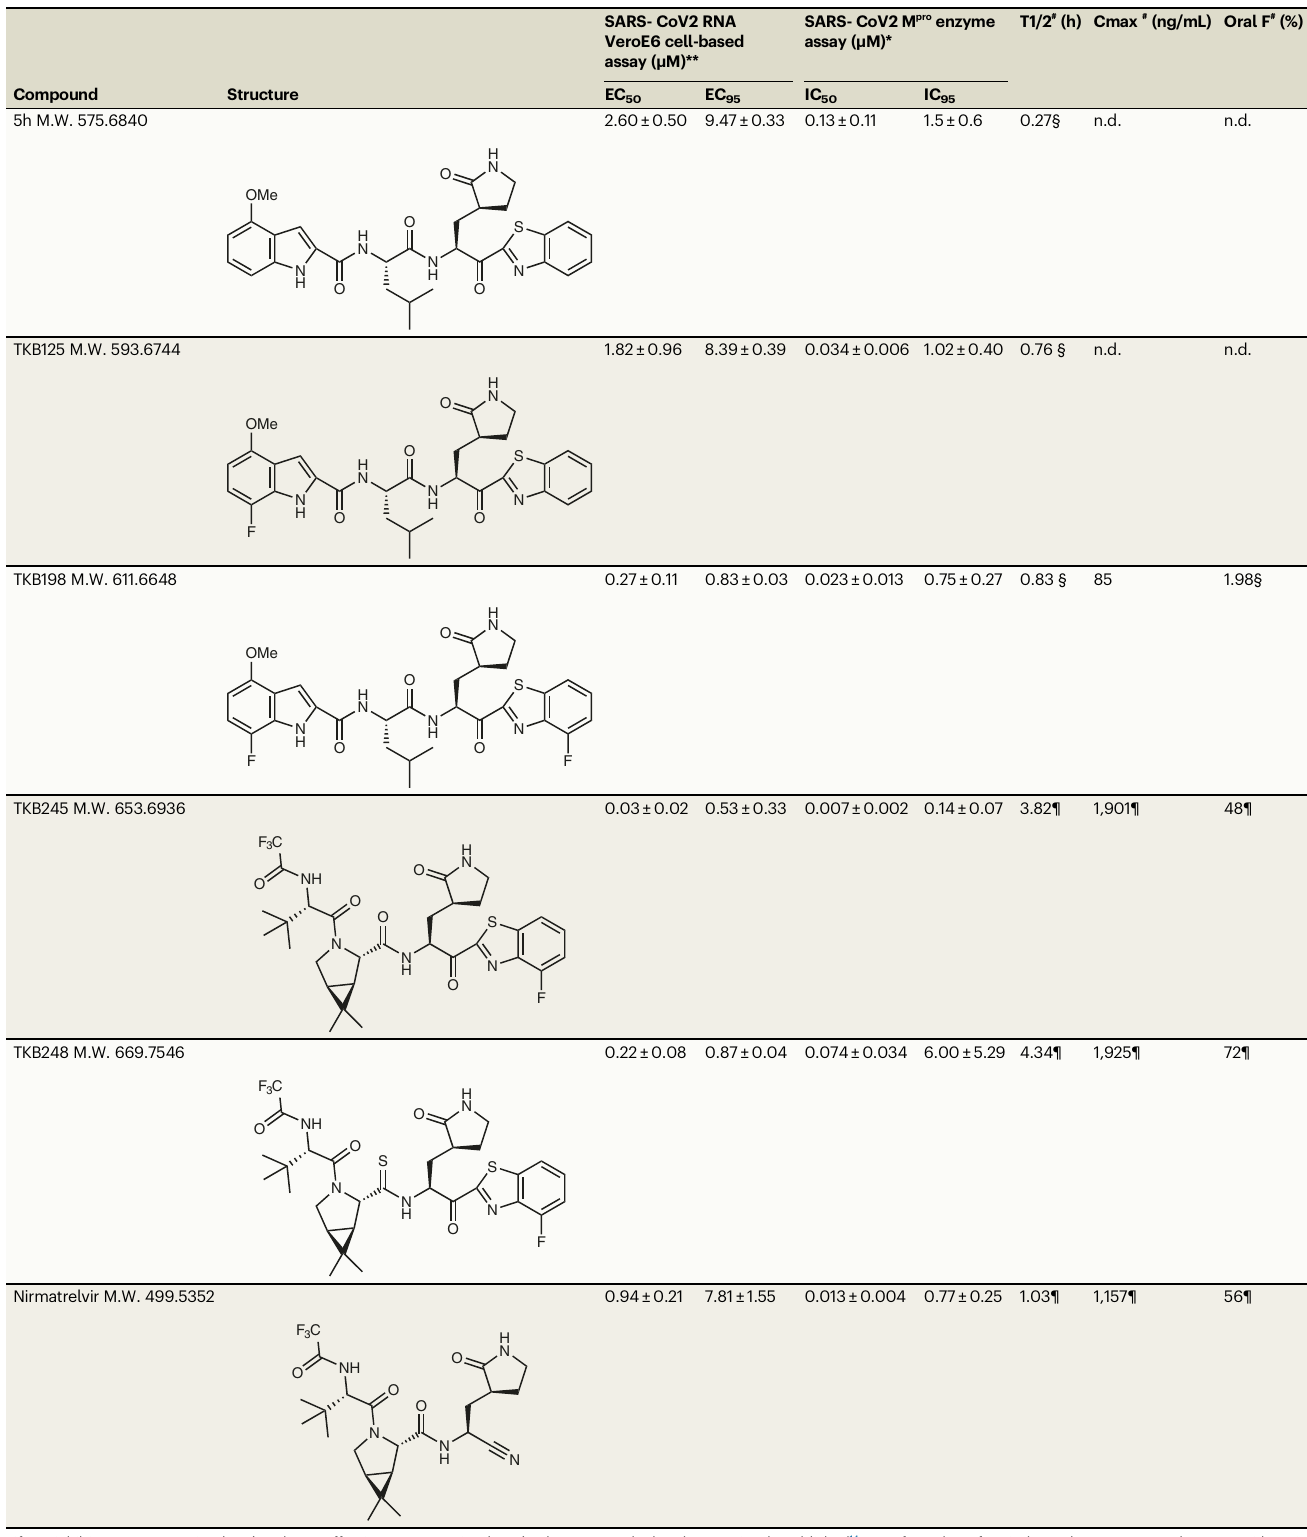
Table 1 | In vitro and in vivo parameters of M pro inhibitors examined in the present